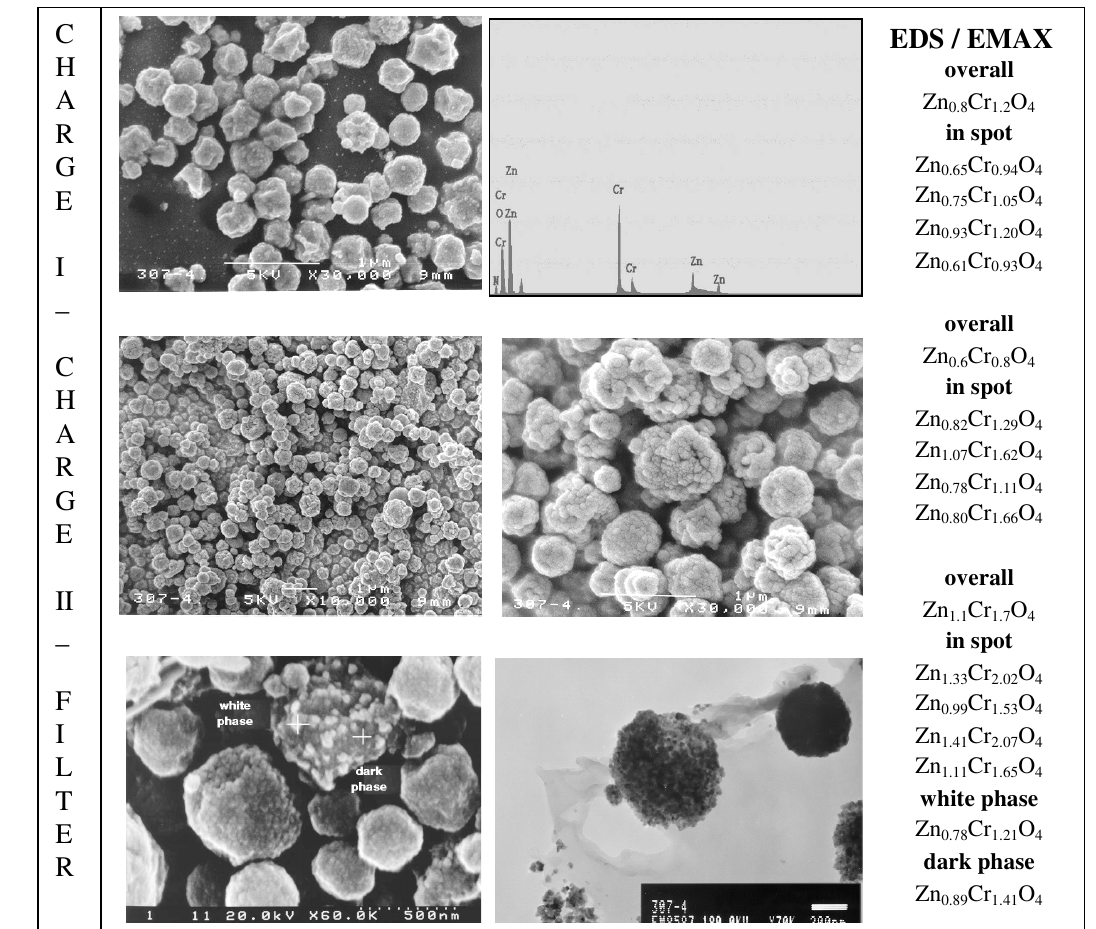
Fig.1 Scanning electron micrographs of the as-prepared ZnCr 2 O 4